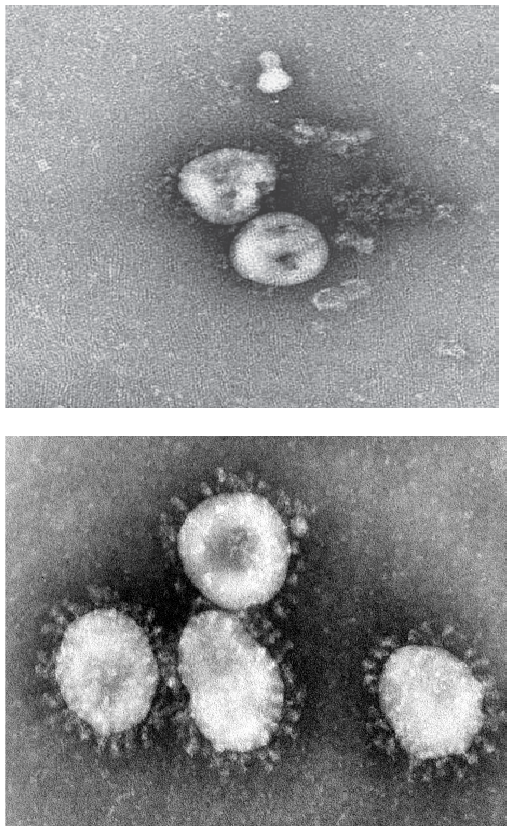
Figure 2(a), 2(b). Coronavirus Spikes [1,